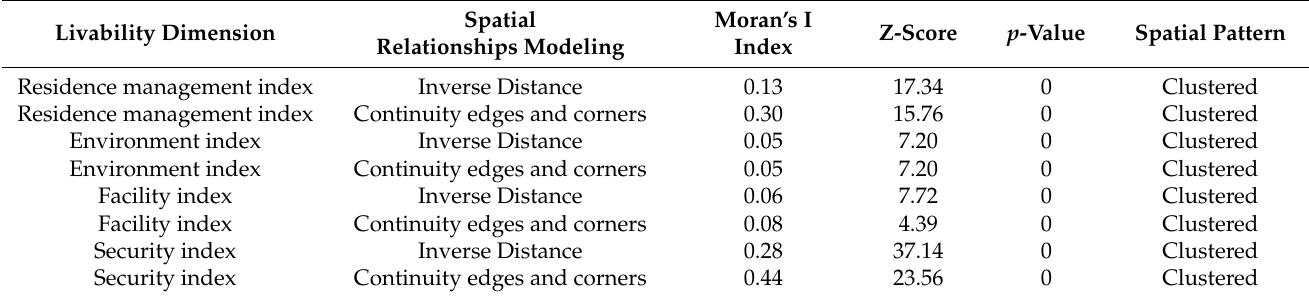
Table 4. Global spatial autocorrelation of community